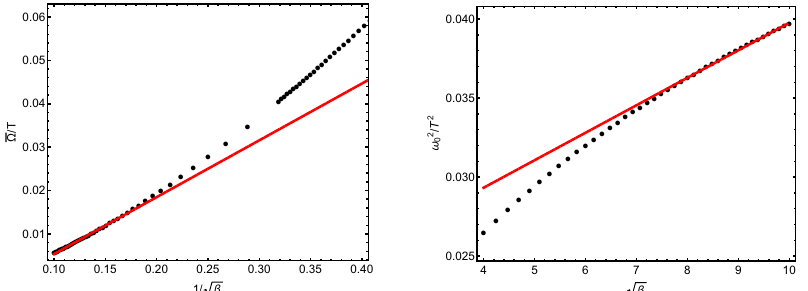
Figure 17 . Dependence of the novel relaxation scale (cid:22)(cid:10) and the pinning frequency ! 0 in function of p the SSB parameter h SSB i (cid:24) (cid:12) . The other parameters are set to m=T = 0 : 3 ; (cid:11) = 0 : 05 such that h EXB i (cid:28) 1. The pseudo-spontaneous regime coincides with (cid:12) (cid:29) 1. There, the red lines guide the eyes towards the linear